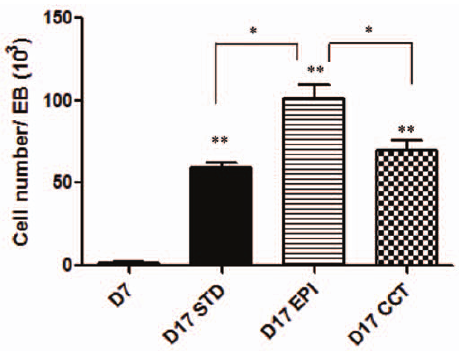
Figure 3. The NPY receptors antagonists blocked epinephrine- induced proliferation of EB cells. Four EBs per well were plated on gelatin-coated 12-well plates at day 7 and treated with insulin (STD), insulin plus epinephrine (EPI), insulin plus EPI and NPY receptors (Y1R + Y2R + Y5R) antagonists (CCT). The number of cells was measured at day 7 and day 17. Values are from three separate experiments each